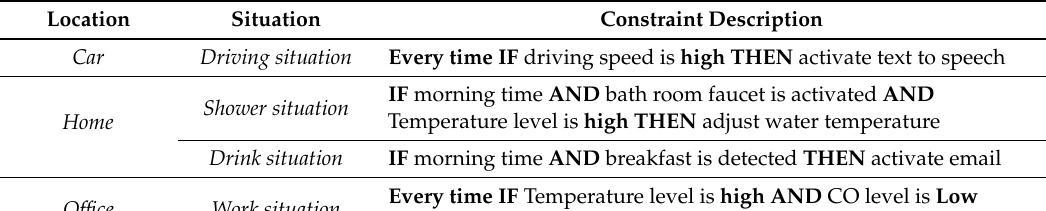
Table 5. Constraints specified by the user.